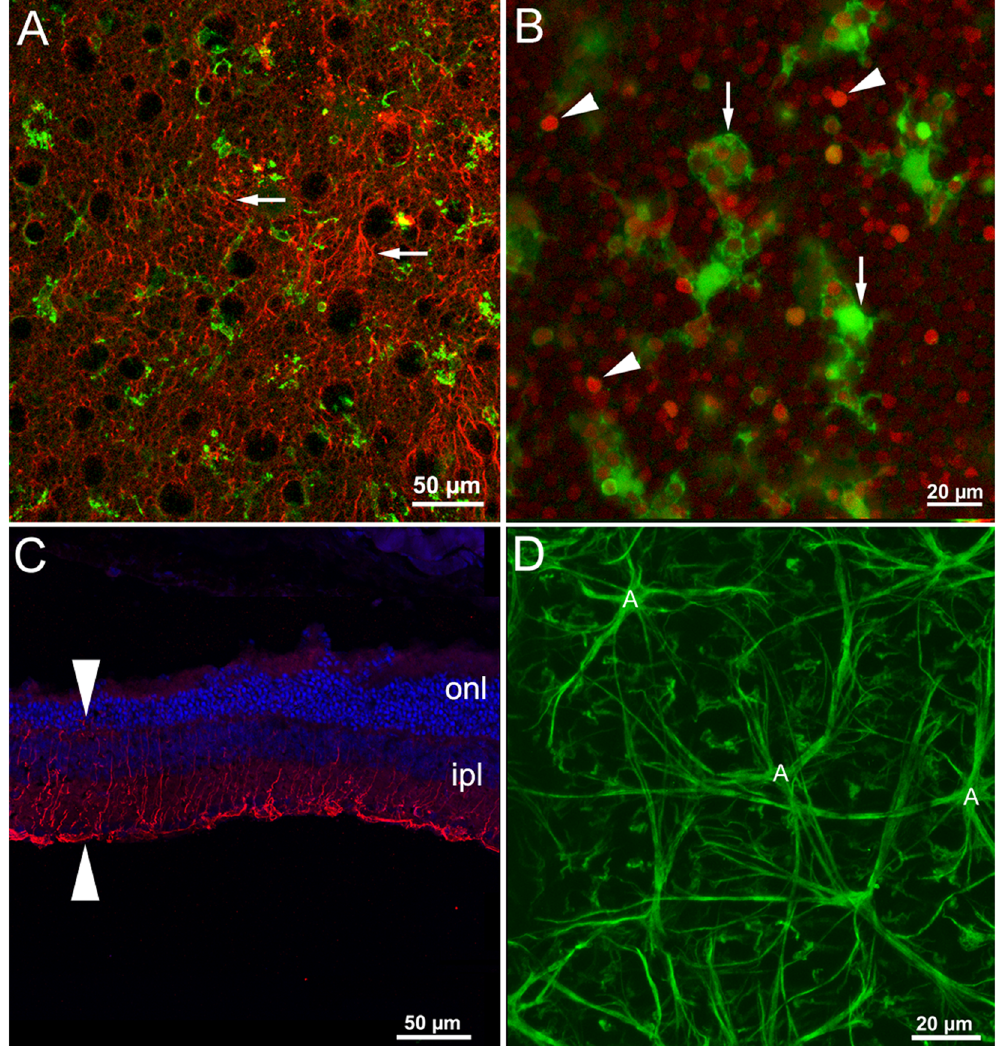
Figure 6. Glial activation. ( A , B ) Macro and microglia in the retina of Tvrm4 mice exposed to 12,000 lux for 1 min and examined after 2 days. ( A ) whole mount ICCH with Iba1 antibodies (green) labels activated microglial cells (arrows) in the outer retina. Red staining: GFAP. ( B ) Pycnotic nuclei of dying photoreceptors (ethidium staining, red) are observed in the ONL (arrowheads) and inside phagocytic microglial cells. ( C ) vertical section stained with antibodies against GFAP (red staining), which highlights the radial processes of activated Muller cells (arrows). Nuclei are stained blue with Hoechst. ( D ) whole mount retina of a Tvrm4 mouse, observed 7 days after exposured. GFAP staining shows hypertrophic processes of astrocytes ( A ) in the corresponding retinal layer, intermingled with Muller cell